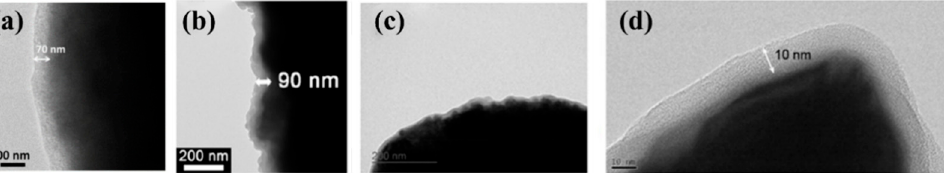
Figure 2. TEM images of K 2 SiF 6 /K 2 TiF 6 with heterogeneous core–shell structures. ( a ) K 2 SiF 6 @MOPAl (Reprinted from Ref [35]. Copyright from John Wiley and Sons Ltd., New York, NY, USA, 2015); ( b